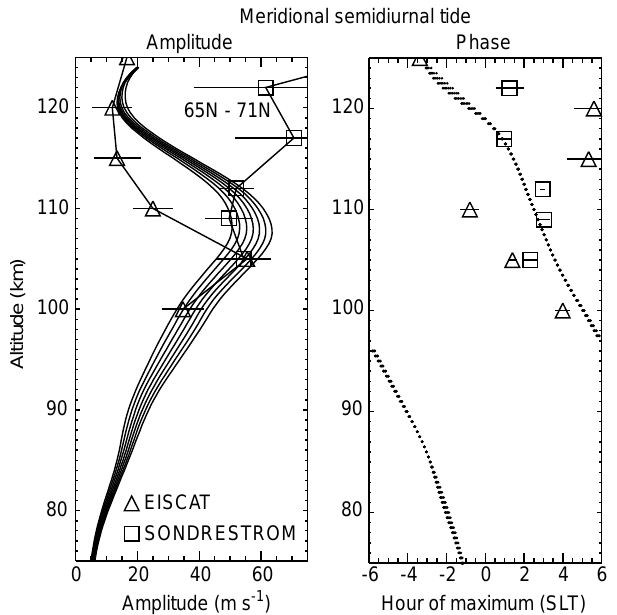
Fig. 8. A comparison of the GSWM meridional semidiurnal tide at high latitudes (65 (cid:14) N–71 (cid:14) N) with observations from the EISCAT (69 (cid:14) N) and Sondrestrom (67 (cid:14) N)